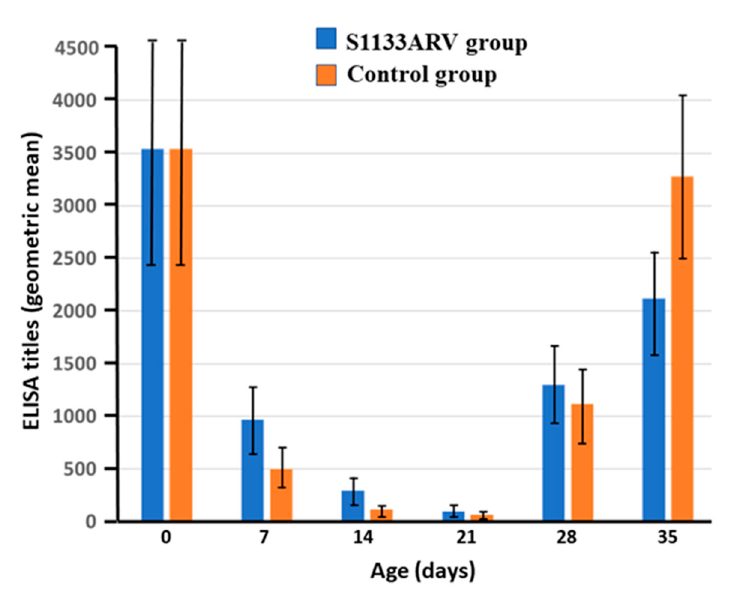
Figure 3. Antibody titers from broilers vaccinated with the avian reovirus S1133 strain ( p > 0.05).